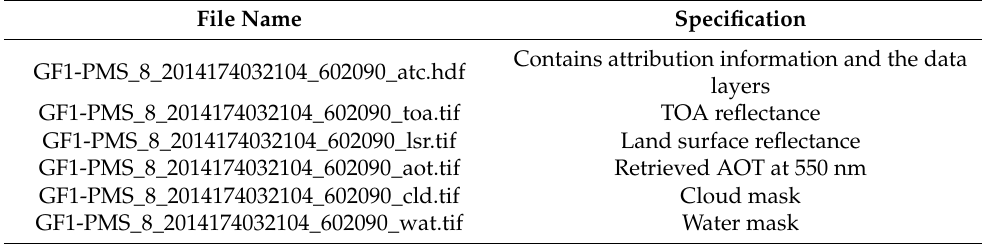
Table 4. Examples of output file names for products retrieved from GF-1